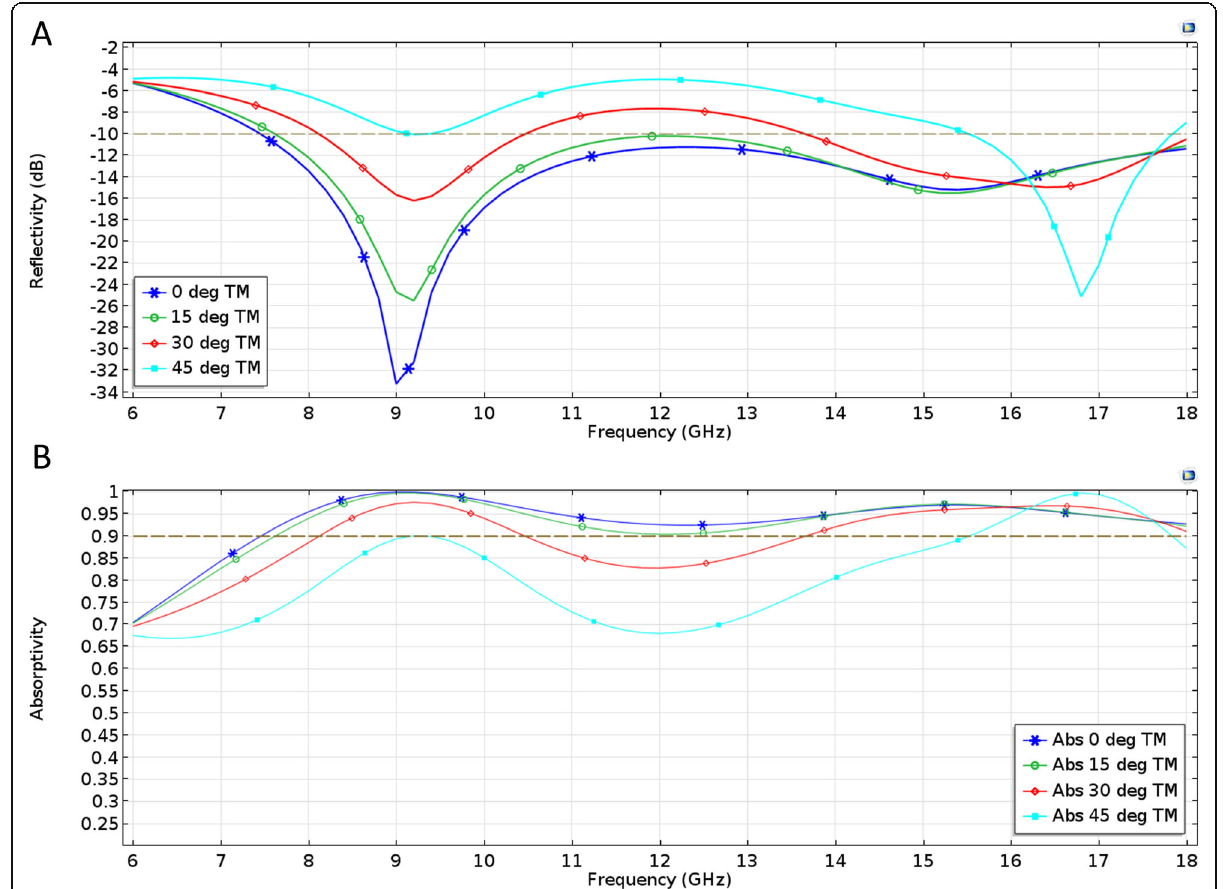
Fig. 10 Simulated reflectivity ( a ) and absorptivity ( b ) of the optimized structure at normal and oblique incidence for TM-polarized wave